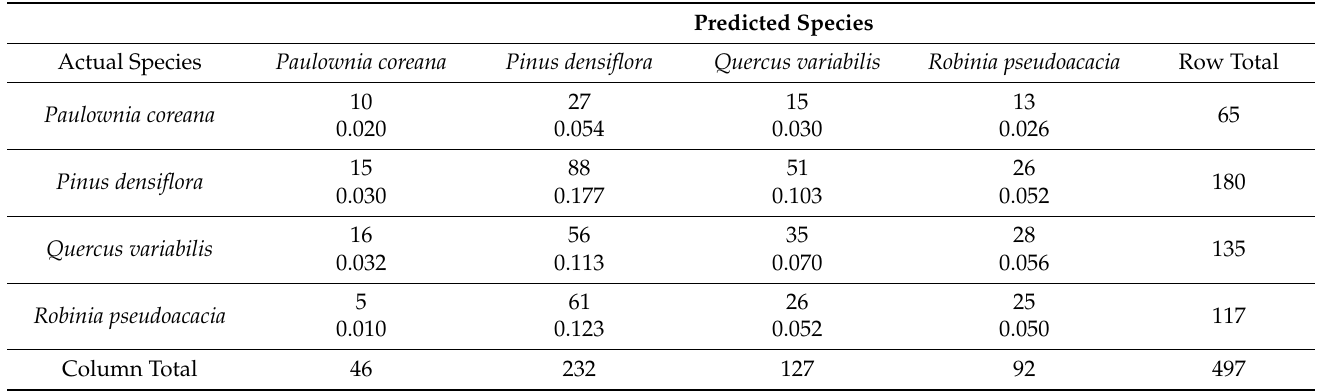
Table 5. Cross tables of predicted and actual species.